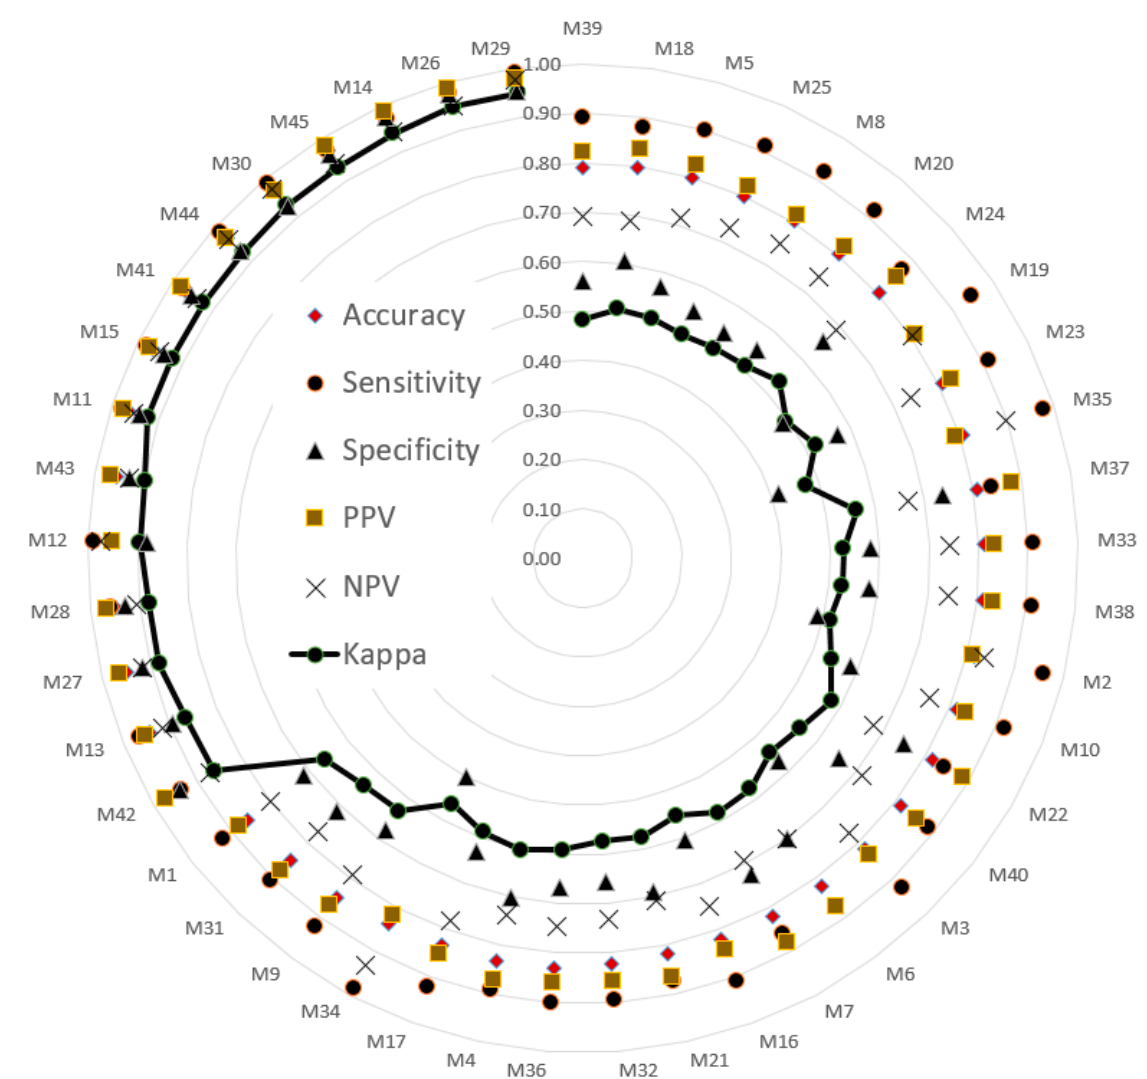
Figure 4. Performance of 45 models using 60% of the data as the training set. Model details are listed in Appendix A Table 3. Models trained with 60% of the data had accuracy and kappa values of no less than 0.95 and 0.88, respectively.